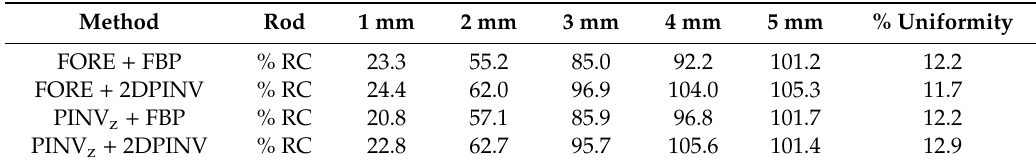
Table 1. Recovery coe ffi cients and uniformity according to NEMA